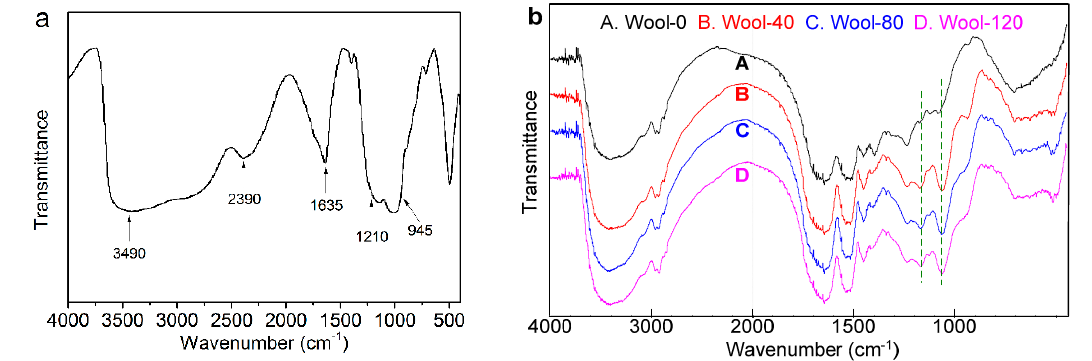
Figure 9. FT-IR spectra of ( a ) PA and ( b ) wool fabrics.